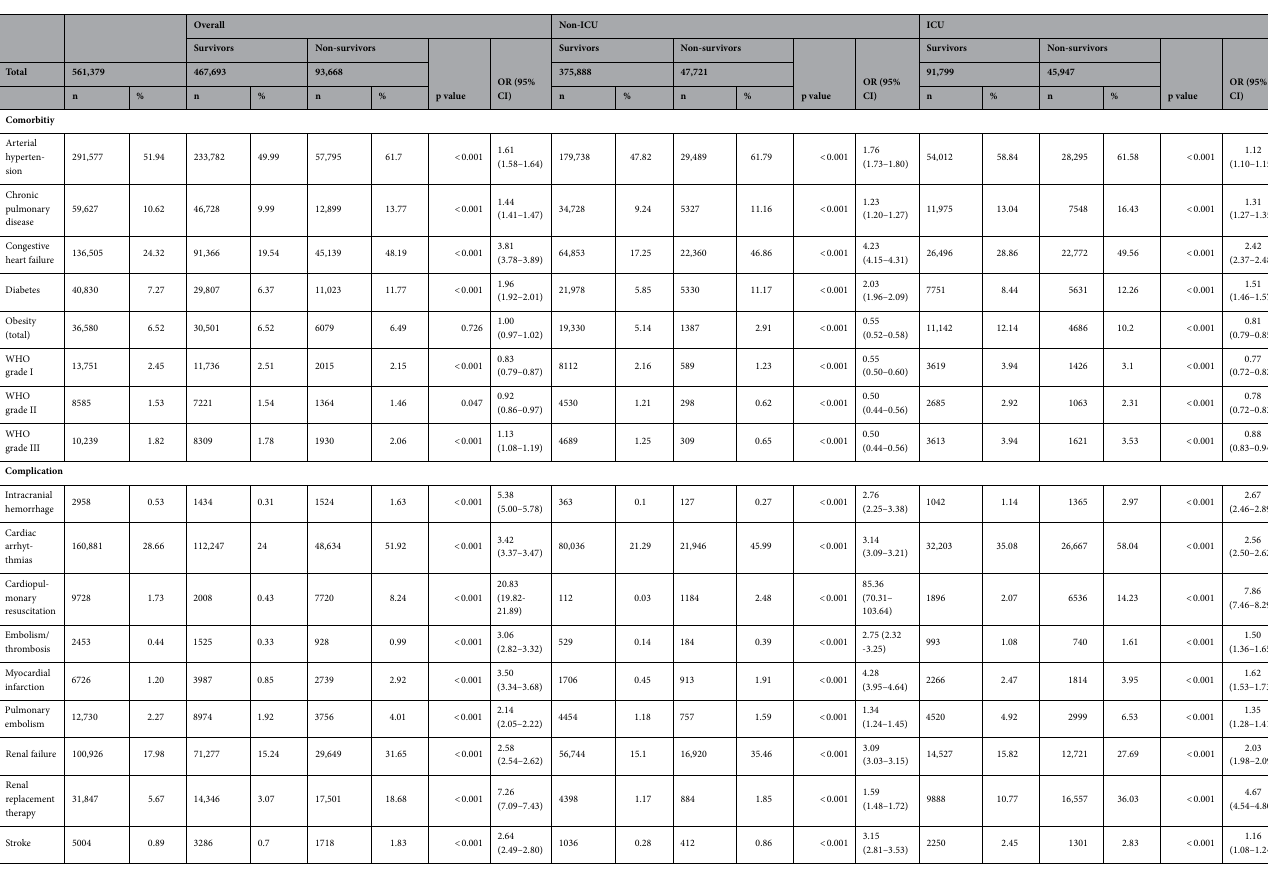
Table 3. Comorbidities and complications. Comorbidities and complications among SARS-CoV-2 positive patients in Germany from Jan 2020 to end of December 2021. The percentages refer column wise to the corresponding group. OR odds ratio, CI confidence